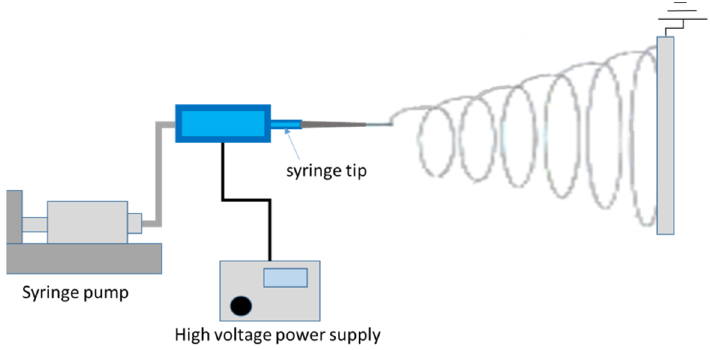
Figure 4. A schematic of the solution-based electrospinning